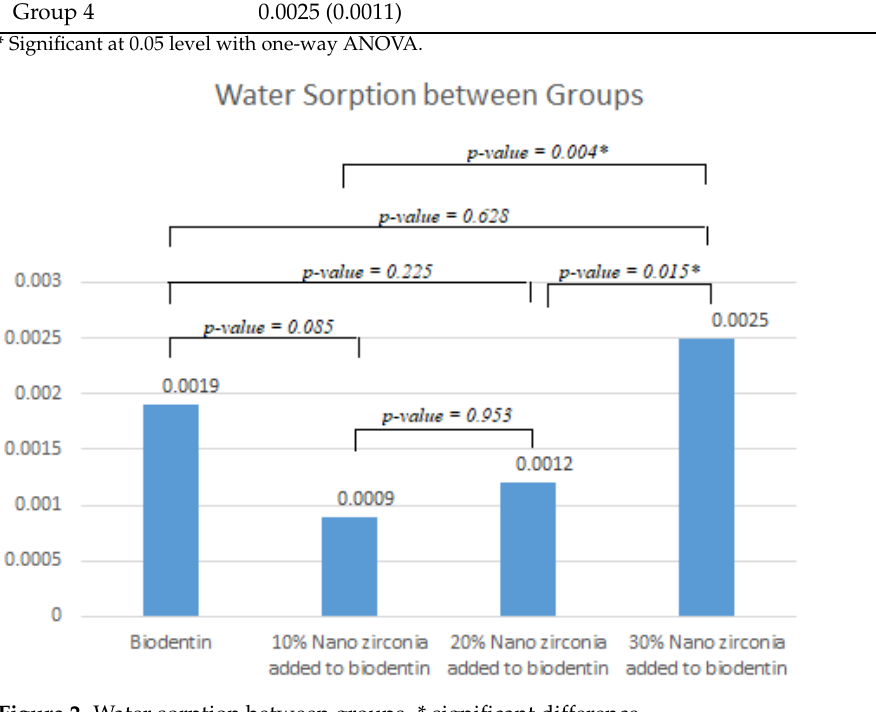
Figure 2. Water sorption between groups. * significant difference.